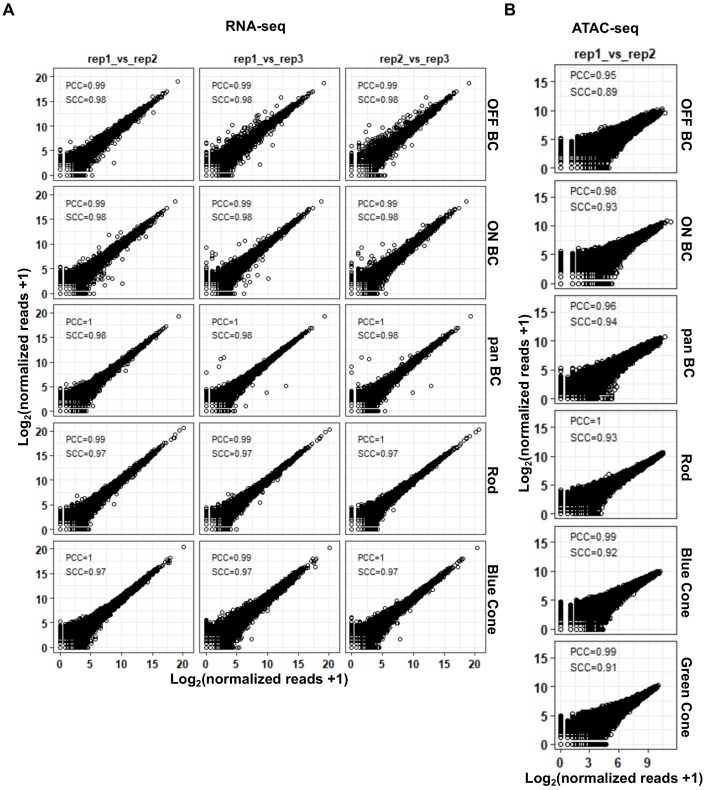
Reproducibility of ATAC-seq and RNA-seq datasets.(A) Pairwise comparison between biological replicates of RNA-seq from purified photoreceptor and bipolar cell populations. For each sample, normalized read counts from one biological replicate are plotted against normalized read counts of another biological replicate. (B) Pairwise comparison between biological replicates of ATAC-seq from purified photoreceptor and bipolar cell populations as in A. PCC: Pearson Correlation Coefficient. SCC: Spearman Correlation Coefficient.